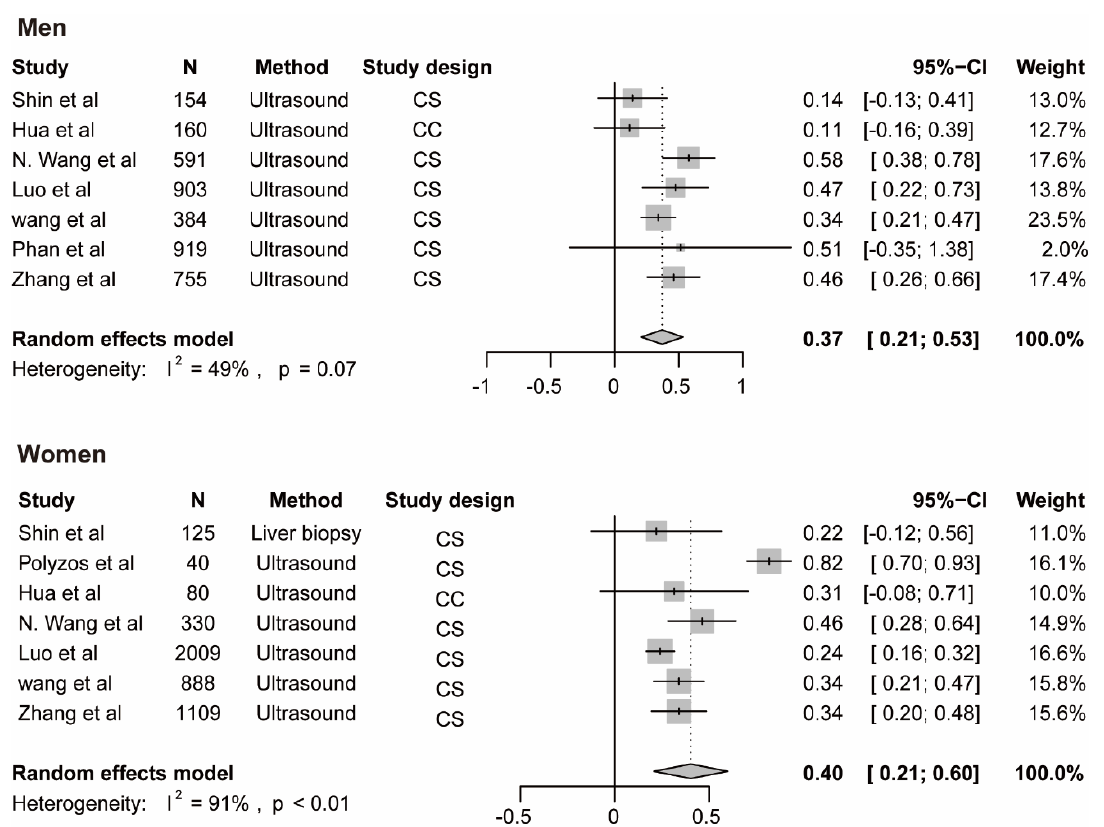
Figure 3. Association of testosterone with NAFLD and results of multivariable meta-regression analysis. ( A ) association of testosterone with NAFLD among men and women. The summary esti- mate (center of diamond) and 95% confidence interval (width of diamond) were synthesized by using a random effect model which is shown in bold. ( B ) the results of multivariable meta-regression analysis based on included studies for analysis of testosterone and NAFLD among men. Abbrevia- tions: NAFLD, non-alcoholic fatty liver disease; CT, computed tomography; CS, cross-sectional; CC, case-control.